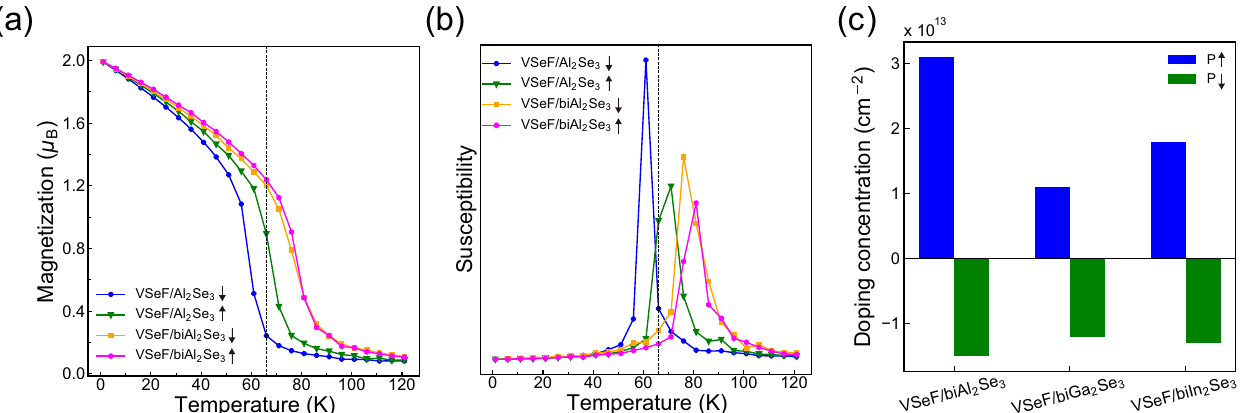
Fig. 5 Doping effect on VSeF layer from FE gates. a , b The variations of magnetic moment and susceptibility as functions of temperature in VSeF/Al 2 Se 3 ( ↓ ) (blue line), VSeF/Al 2 Se 3 ( ↑ ) (green line), VSeF/biAl 2 Se 3 ( ↓ ) (orange line) and VSeF/biAl 2 Se 3 ( ↑ ) (magenta line) heterostructures. The black dashed line indicates the T c value of pristine VSeF monolayer. c The doping concentration of VSeF layer under different FE substrates (bilayer Al 2 Se 3 , bilayer Ga 2 Se 3 and bilayer In 2 Se 3 ) and FE polarized states (upward polarization or downward polarization). The blue and green bars depict the doping concentrations from upward and downward electric polarized FE gates, respectively. The positive and negative doping concentration indicate electron and hole doping,